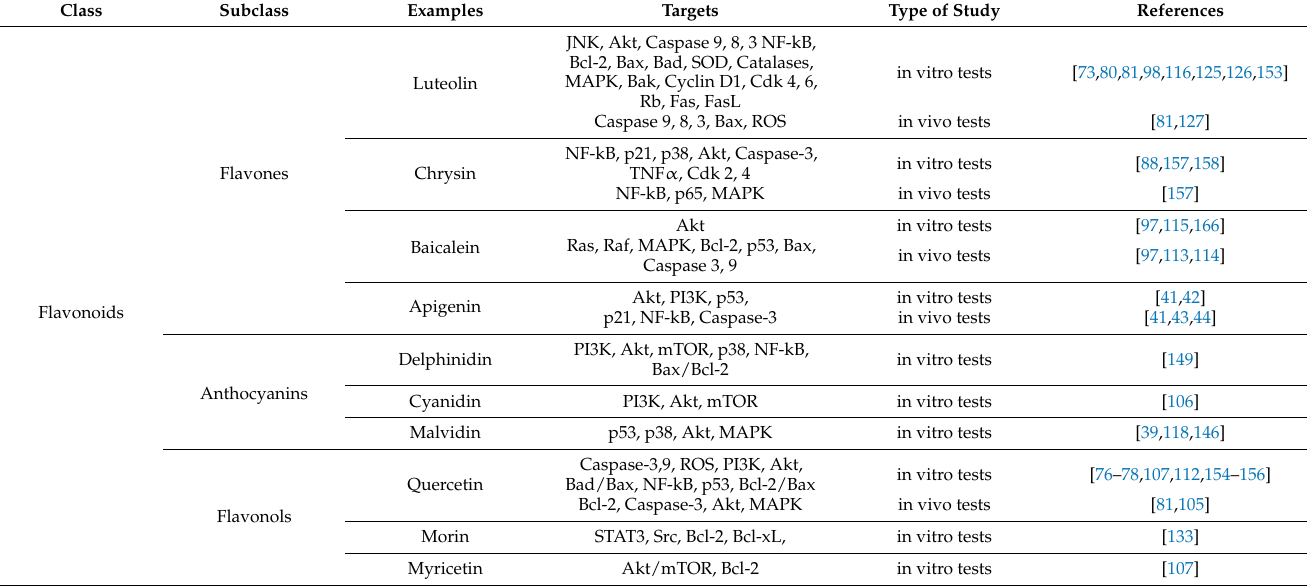
Table 1. Examples of colored secondary metabolites and their targets in cancer